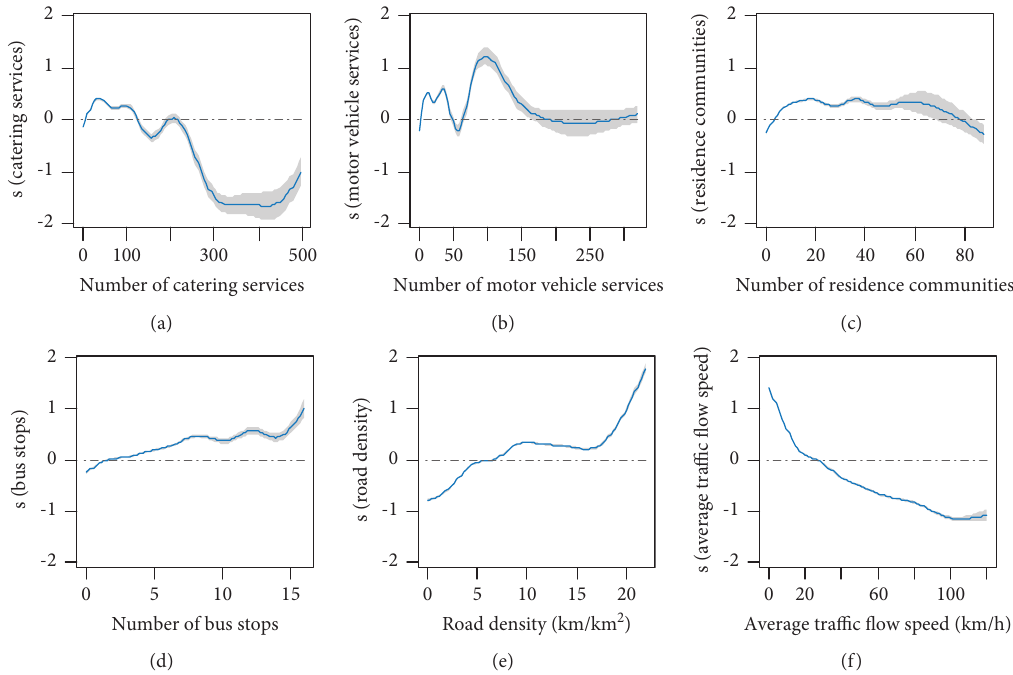
Figure 6: Estimated degrees of freedom with smooth spline functions on taxi vacant time for explanatory variables. (a) Number of catering services. (b) Number of motor vehicle services. (c) Number of residence communities. (d) Number of bus stops. (e)Road density (km/km 2 ). (f) Average traffic flow speed (km/h). Note: the horizontal coordinate indicates the actual value of each explanatory variable, the vertical axis indicates the value of the smooth function, the shading indicates the upper and lower limits of the confidence interval, and the solid line indicates the smooth fitted curve of each explanatory